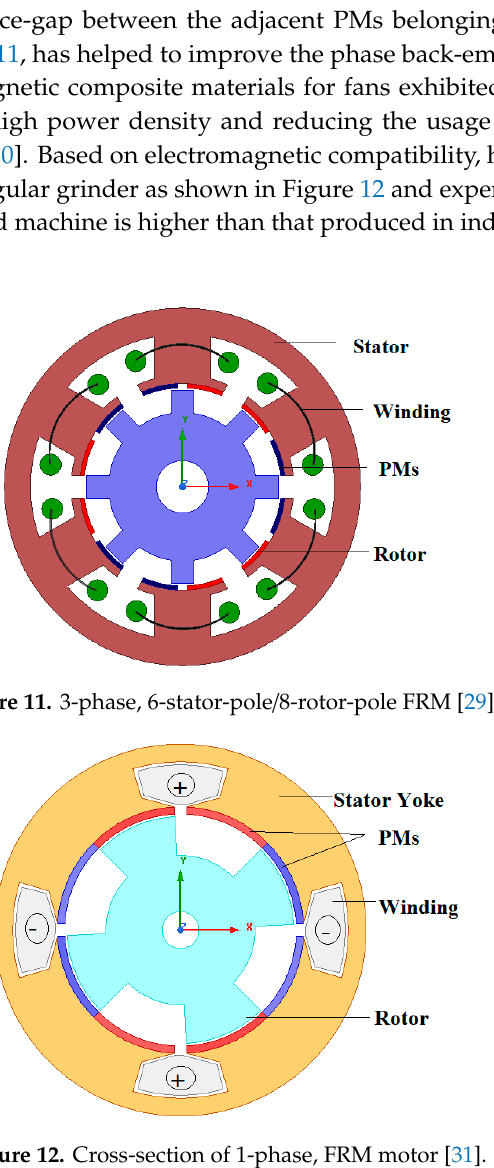
Figure 12. Cross-section of 1-phase, FRM motor [31].